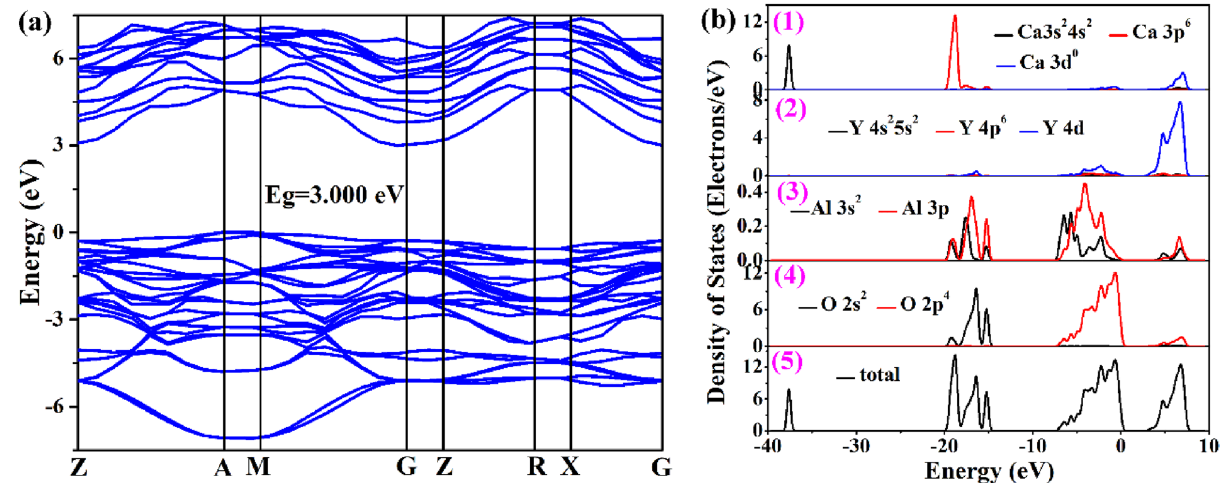
Figure 2. ( a ) Calculated band structure of CYA; ( b ) electronic DOS of CYA: (1)–(4) the partial DOS of Ca, Y, Al, O and (5) the total DOS.